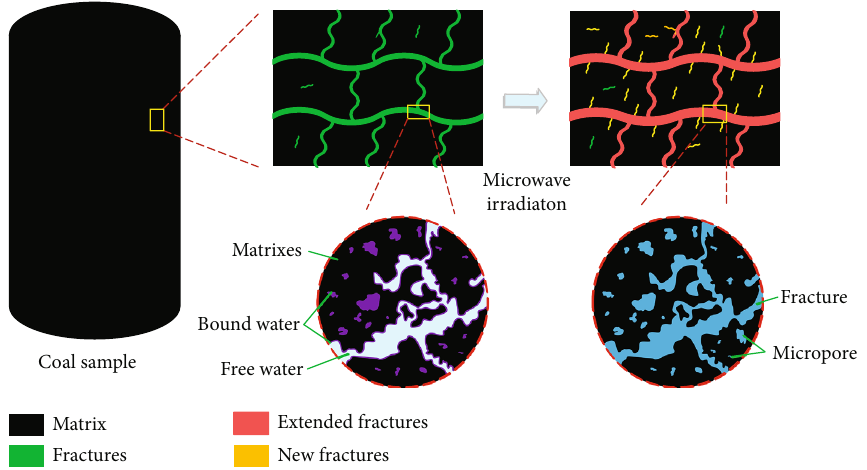
Figure 15: Schematic diagram for the coal seam after microwave heating stimulation.